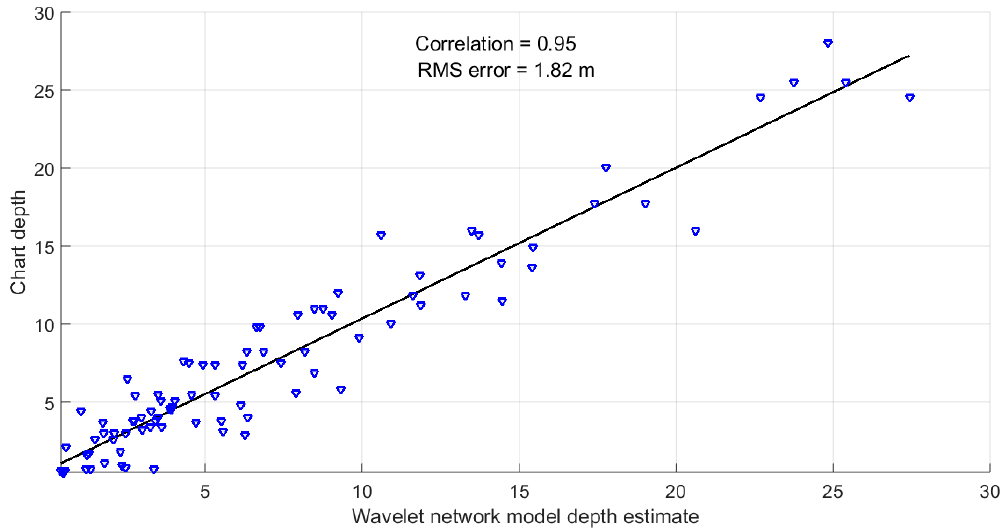
Figure 7. The correlation between modelled/validated depth estimates and “truth” nautical chart depths for the 90 collocated stations using the wavelet network model.